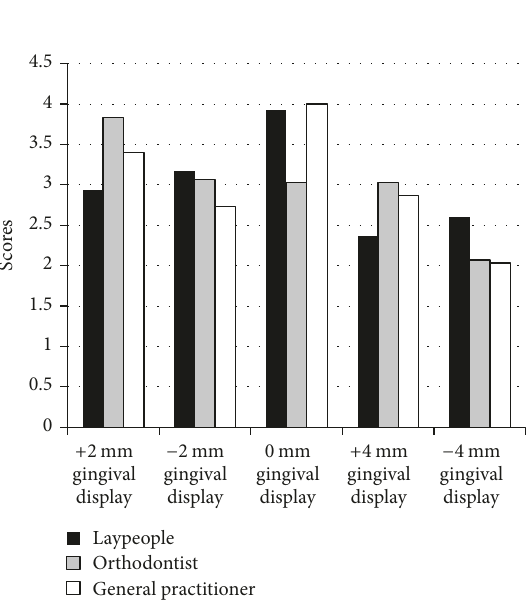
Figure 4: Graphic illustration of numerical rating scale means among groups for long